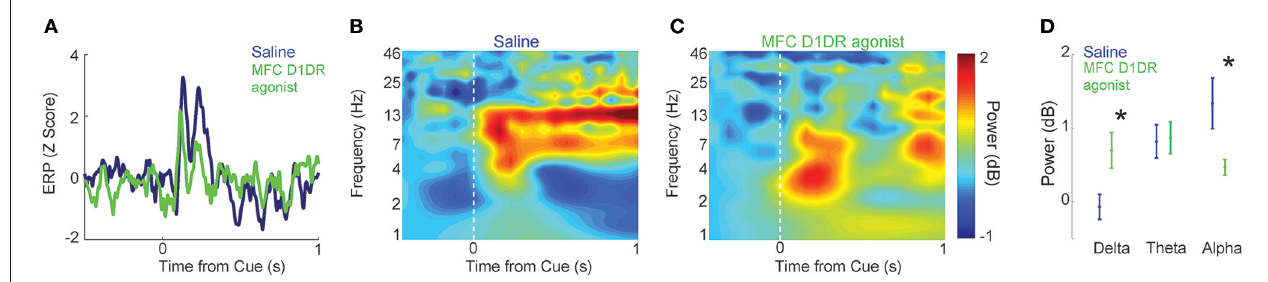
FIGURE 4 | MFC D1DR agonists influence oscillatory patterns of MFC LFP during interval timing tasks. (A) Event-related potentials from all LFP channels in 7 rodents (17 channels) revealed a stimulus-triggered peak the MFC after stimulus onset. MFC ERP is unaffected by MFC D1DR agonists. (B) Time-frequency analysis revealed a burst of activity from 4 to 15Hz following the onset of the cue. (C,D) Infusions of MFC D1DR agonist significantly increased delta activity between 1 and 4Hz and attenuated alpha activity between 8 and 15Hz while theta activity was unaffected. Asterisk represents significance at p < 0.05 via a t